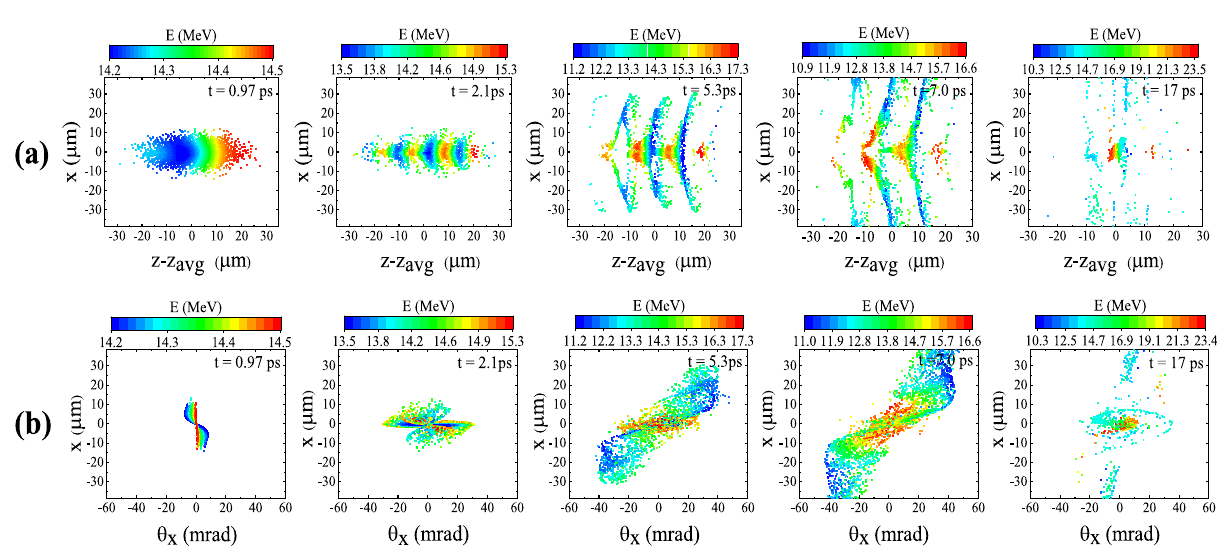
Figure 6. Snapshots showing (a) the spatial distribution, and (b) the trace-space θ x – x of an electron bunch 30 ) injected behind a 30 fs laser pulse with a 0 =0.25 at different with an initial energy of 14.8 MeV ( P z 0 / m e c = propagation